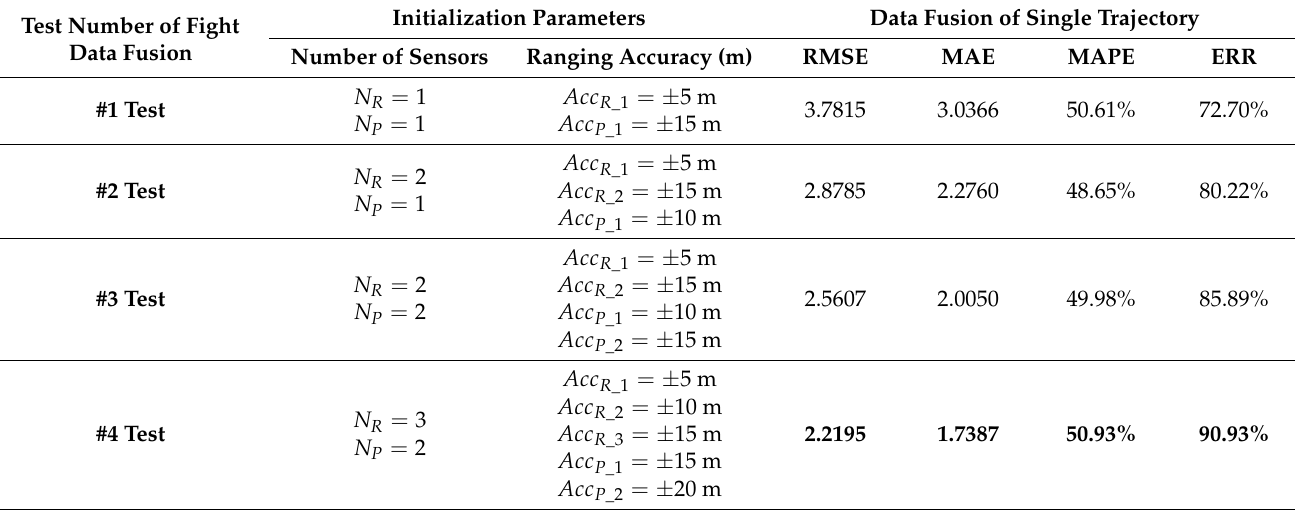
Table 5. The error data statistics of absolute